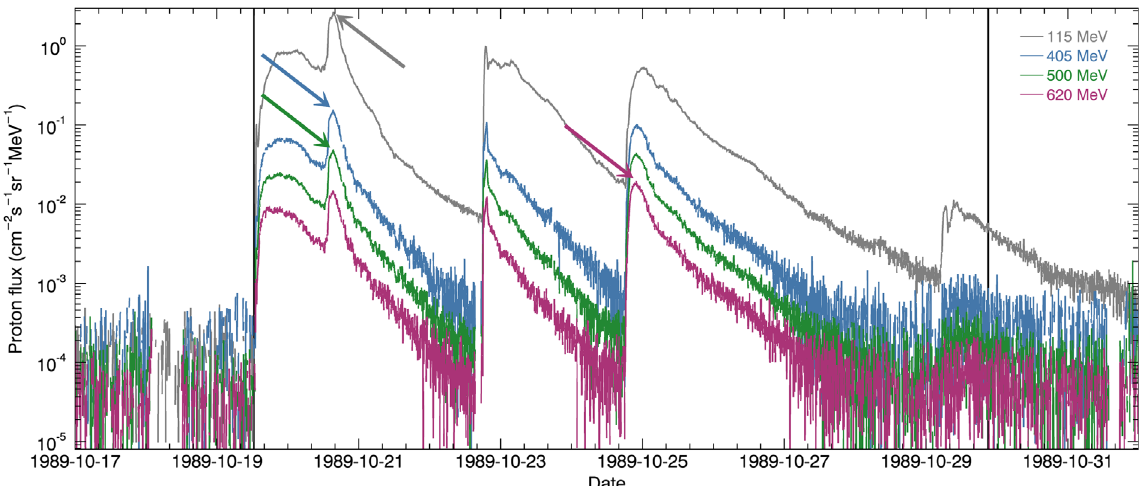
Fig. 2. The October 1989 solar energetic particle episode. HEPAD fl uxes inter/extrapolated to 405 MeV, 500 MeV and 620 MeV are shown in blue, green and purple, respectively, and the 115 MeV SEPEM channel is shown in grey. The vertical lines show the onset and ending times of the episode. The arrows show the location of the maximum fl ux on each